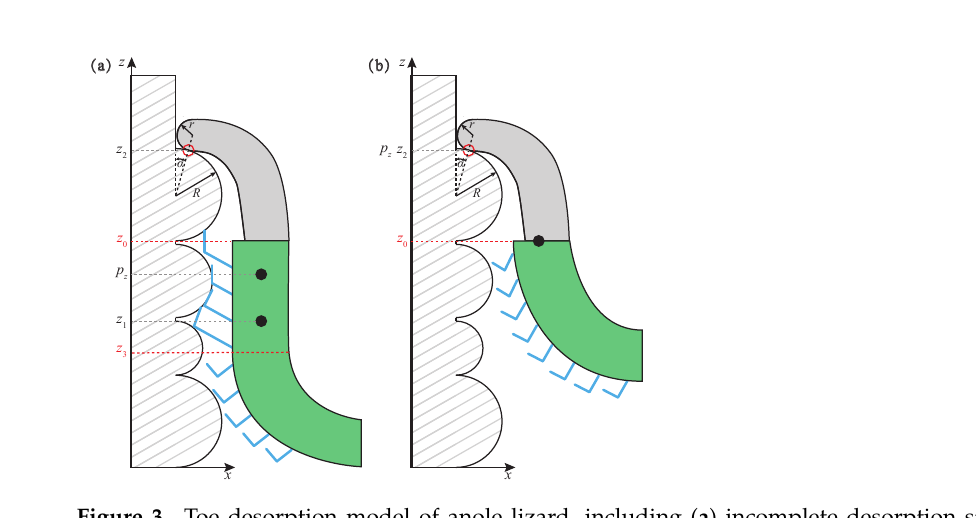
Figure 3. Toe desorption model of anole lizard, including ( a ) incomplete desorption state and ( b ) complete desorption